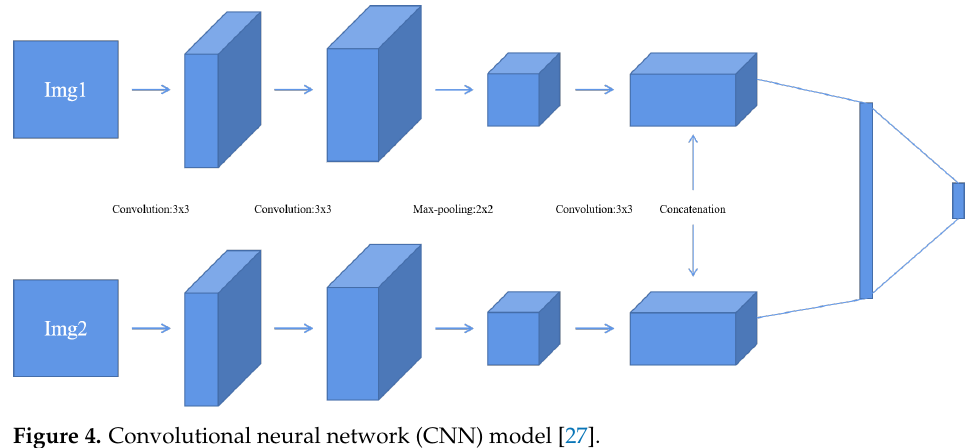
Figure 4. Convolutional neural network (CNN) model [27].